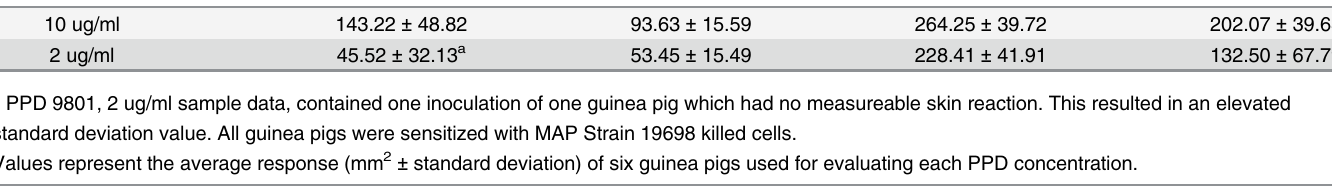
Table 2. Guinea pig potency skin test responses at 24 hours post-inoculation of MAP PPD. PPD